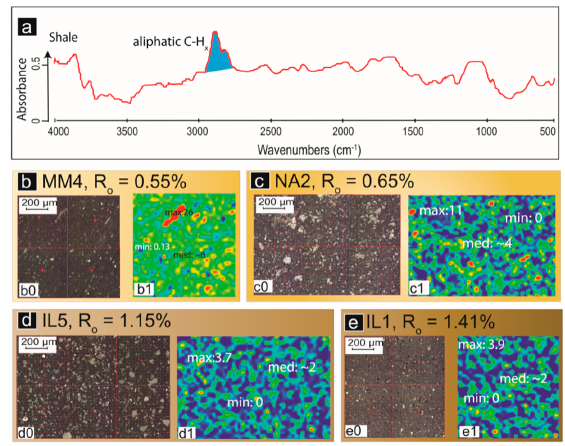
Figure 7. ( a ) A representative FTIR spectrum of the studied shale samples. The blue-filled areas represent the absorbance values that are mapped in panels b1 , c1 , d1 and e1 . Micro-FTIR chemical maps of organic matter in ( b ) early mature shale MM4; b0 :photomicrograph; b1 :micro-FTIR chemistry map of integrated peak area of aliphatic CH x groups; ( c ) mature shale NA2; c0 : photomicrograph; c1 :micro-FTIR chemistry map of integrated peak area of aliphatic CH x groups; ( d ) late mature shale IL5; d0 : photomicrograph; d1 : micro-FTIR chemistry map of integrated peak area of aliphatic CH x groups; and ( e ) postmature shale IL1; e0 : photomicrograph; e1 : micro-FTIR chemistry map of integrated peak area of aliphatic CH x groups. Min, med, and max values stand for the minimum, median, and maximum values of integrated peak areas of aliphatic CH x groups in 3000–2800 cm − 1 . Modified after figure 4 in Chen et al. [40] with copyright permission from John Wiley and Sons.